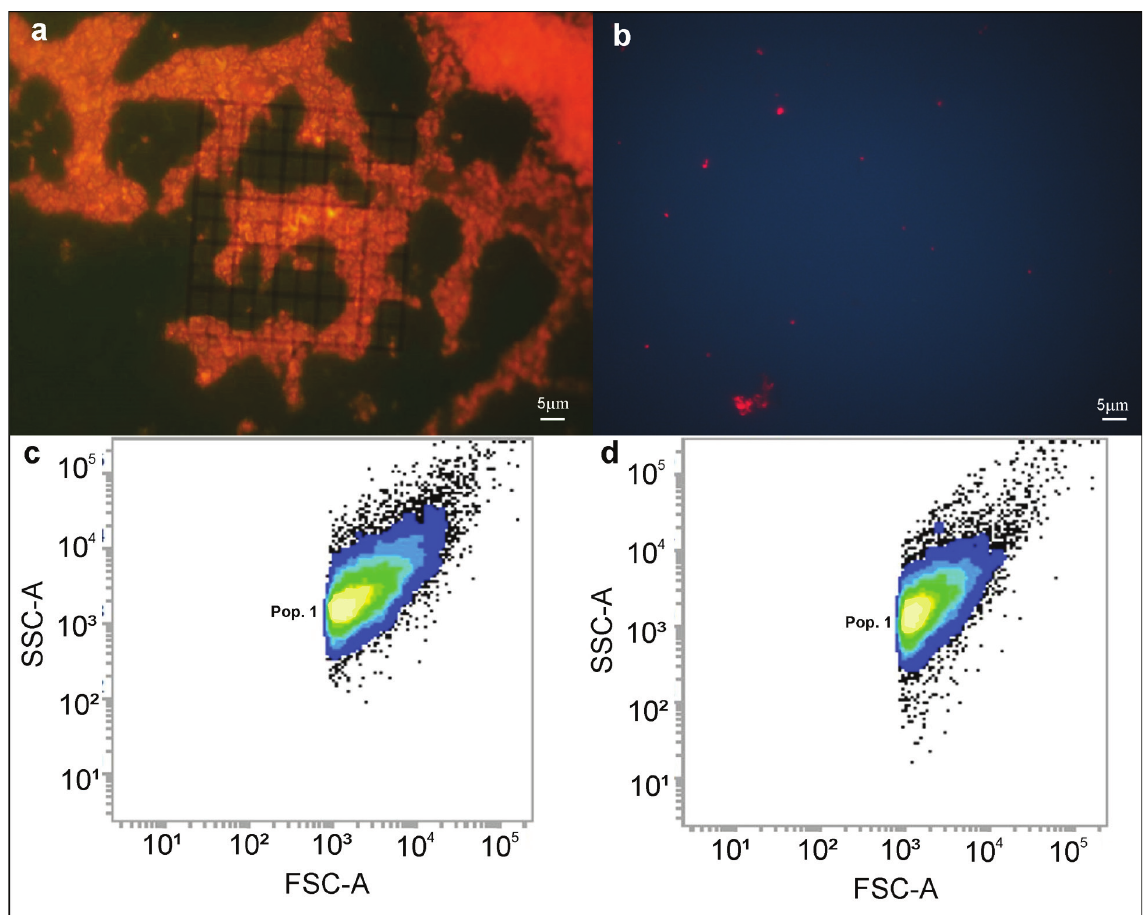
Figure 4 - Comparison of biofilm bacterial communities between control (a) and T2 (b) with the evaluation of the population of bacteria by flow cytometer after 10,000 acquired events on control (c) and T2 (d). Lighter colours are related to higher density cells. For interpretation of the references to color in this figure legend, the reader is referred to the web version of this